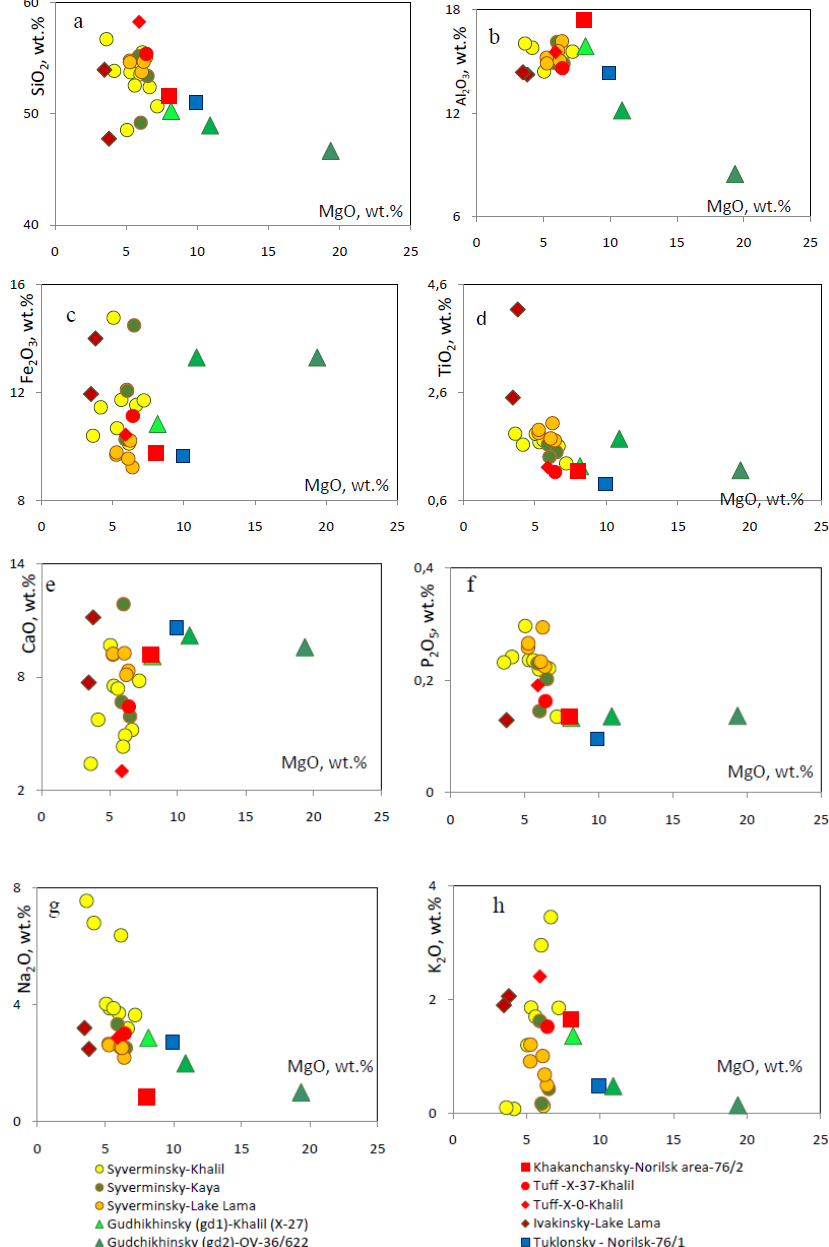
Figure 10. Diagrams MgO vs. SiO 2 ( a ), Al 2 O 3 ( b ), Fe 2 O 3 ( c ), TiO 2 ( d ), CaO ( e ), P 2 O 5 ( f ), Na 2 O ( g ), and K 2 O ( h ).